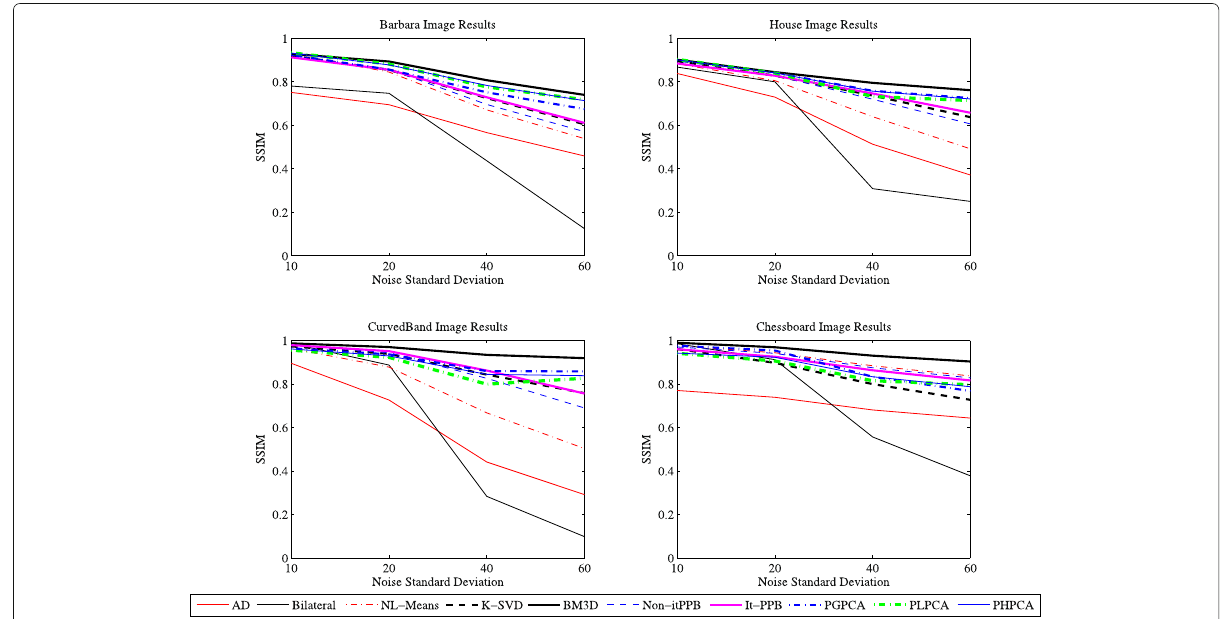
Fig. 11 Denoising methods performance: the performance of the denoising methods for the four images at various noise levels (σ)